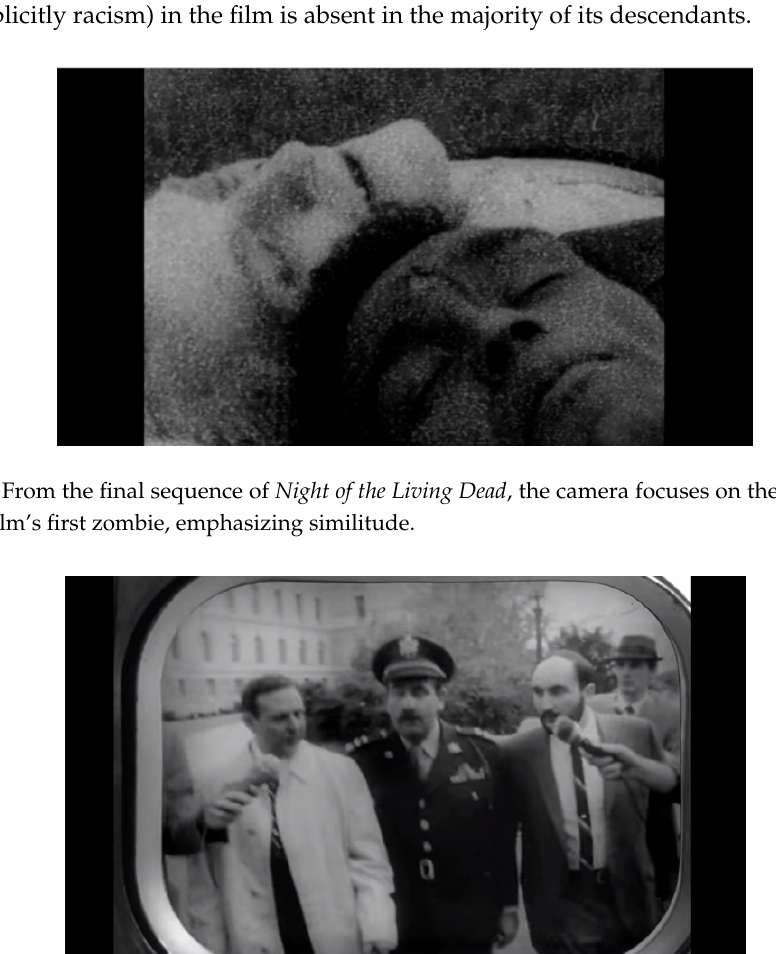
Figure 4. The TV frames our view, putting us in the room with the survivors. The framing of